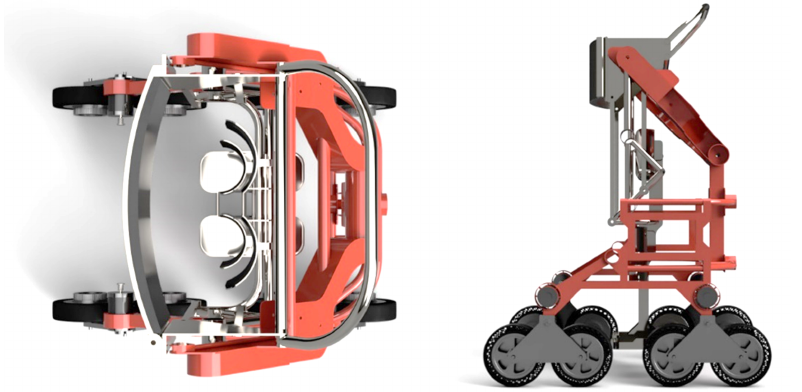
Figure 2. ( Left ) Top View of the mechatronic device. ( Right ) Lateral View of the mechatronic device.